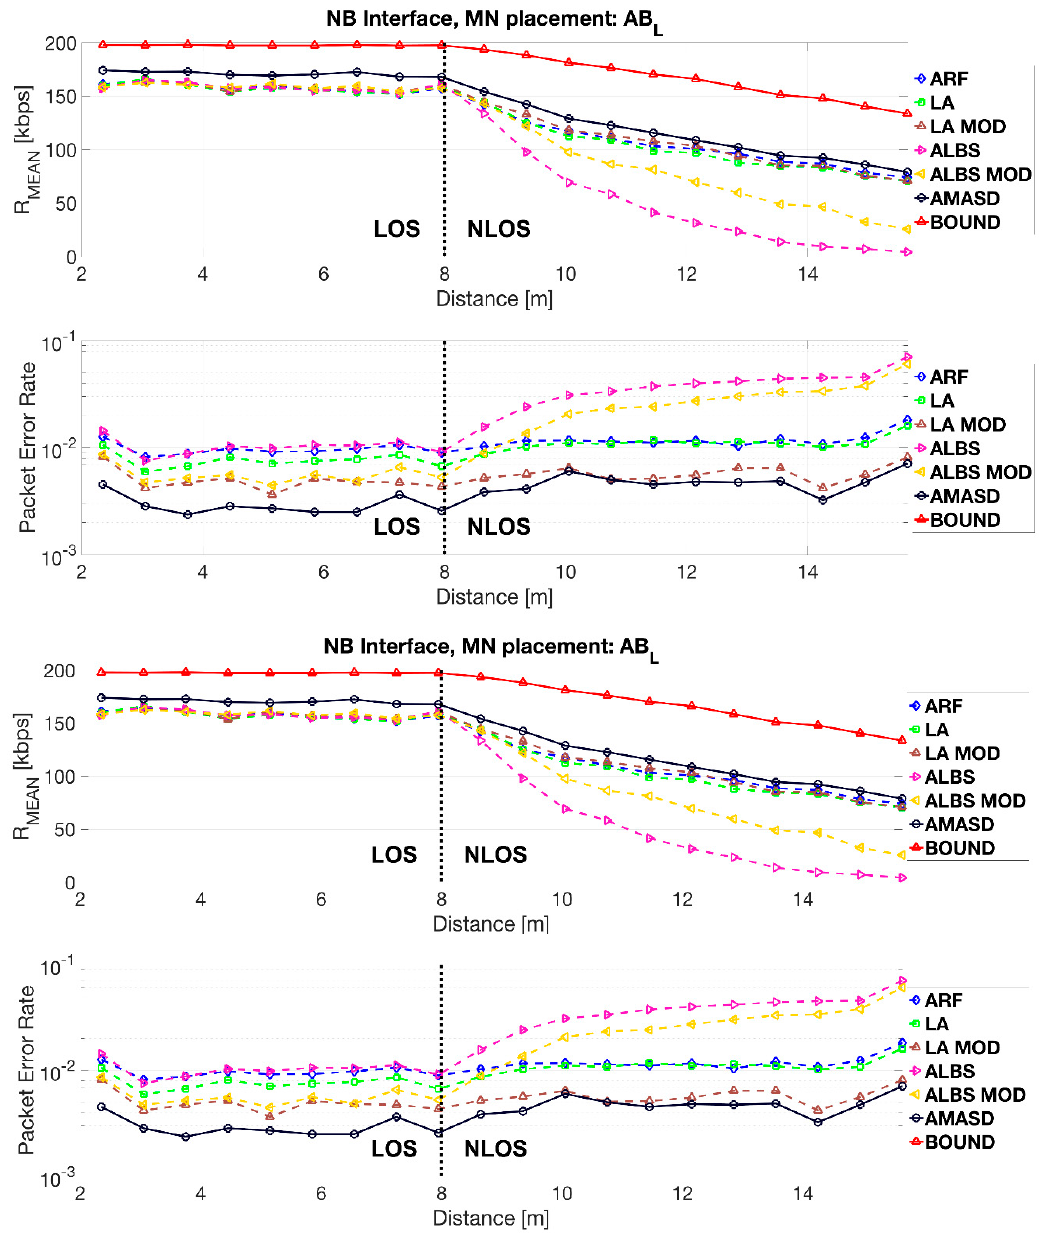
Figure 10. The R MEAN and PER results as a function of the distance for the AB L MN placement for NB and UWB interfaces .